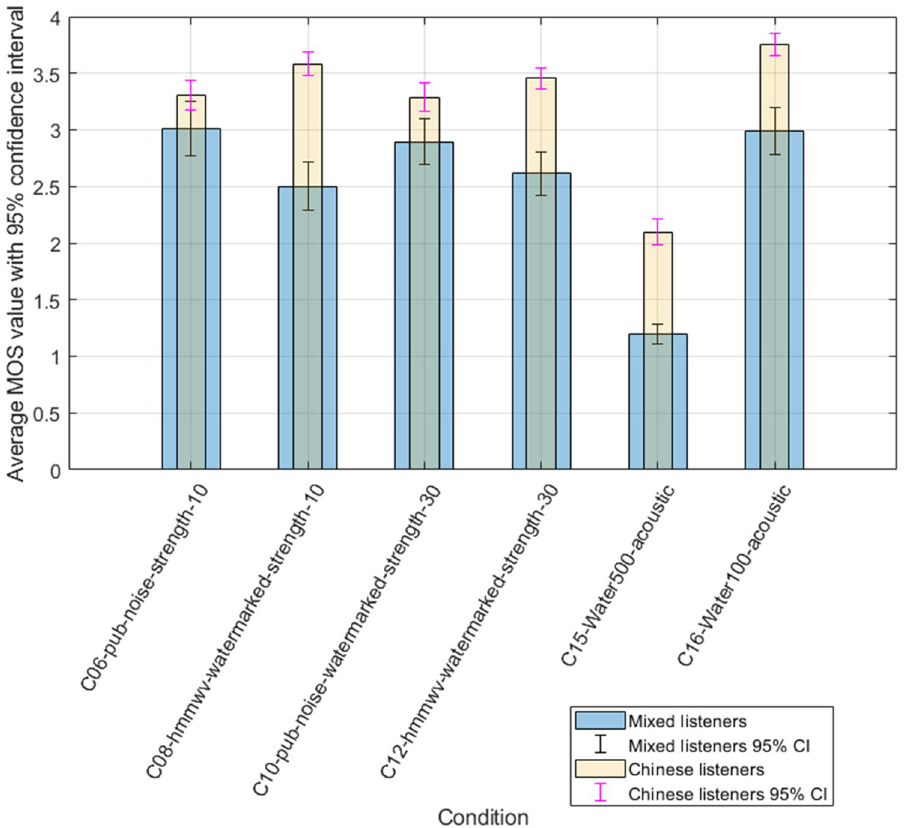
Figure 7. Comparison of watermarked noise conditions between mixed and Chinese